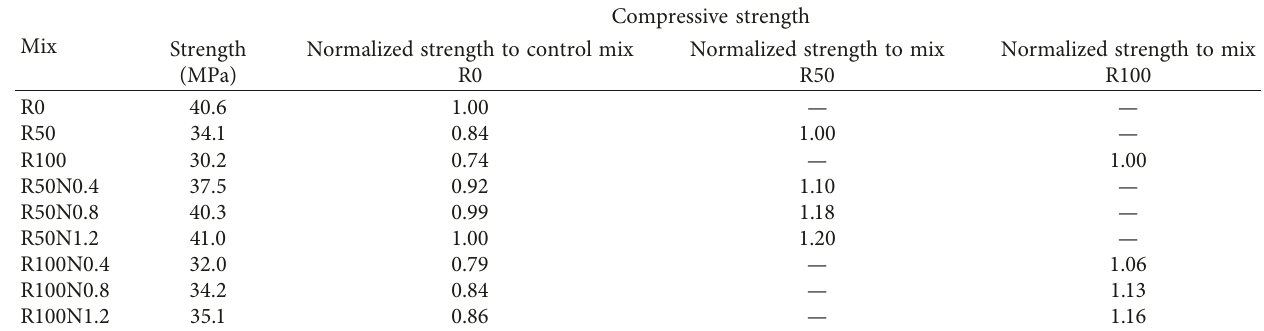
Table 3: Results of compressive strength test.